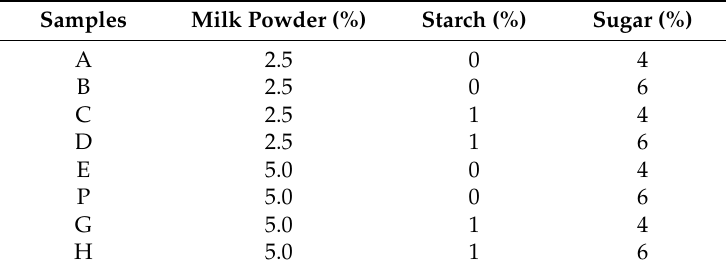
Table 1. Concentrations used in the formulation of samples 1